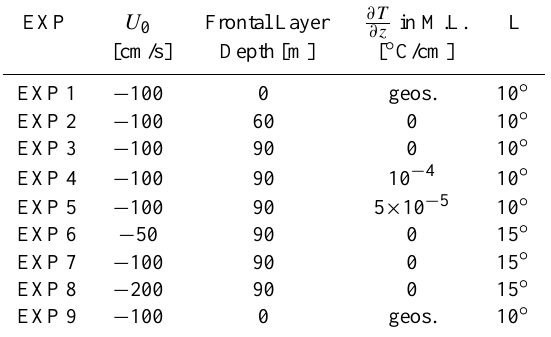
Table 1. List of experiments. First column: experiment names. Second column: parameter used in Eq. (8) in cm/s. Third column: frontal layer depth in meters. Fourth column: vertical temperature gradient inside the frontal layer in ◦ C/cm. Fifth column: zonal length of the domain in